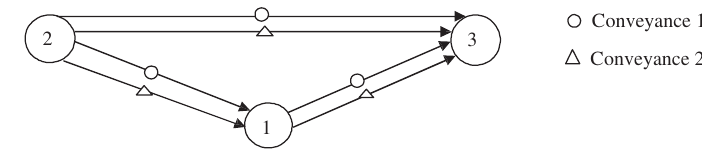
Figure 1: Network Representing Fully Fuzzy CSMCF Problem. Table 1: Fuzzy Penalties